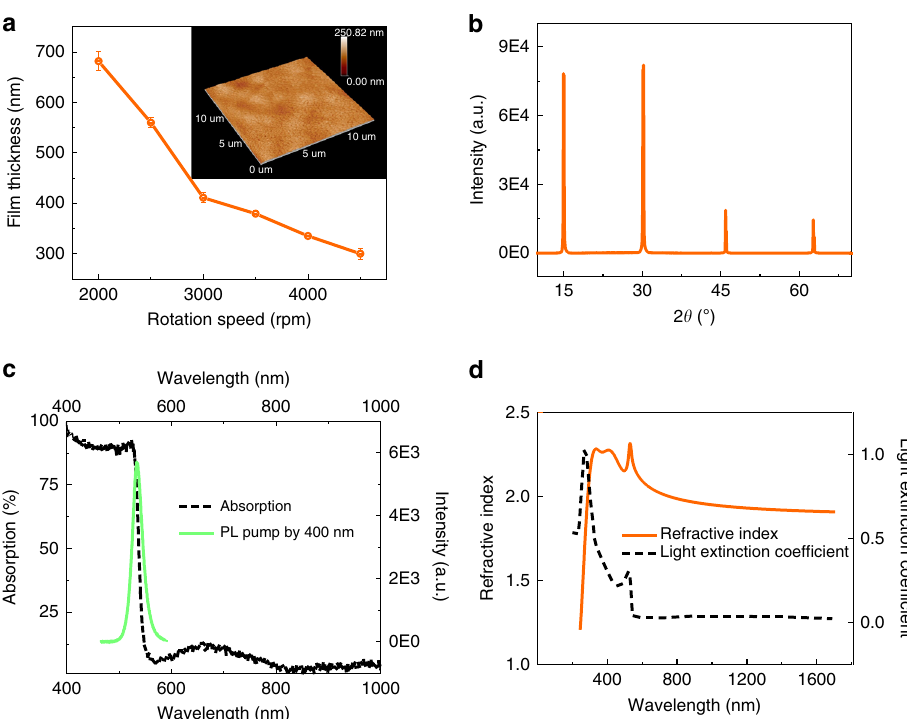
Fig. 1 The synthesized MAPbBr 3 perovskite fi lm. a The thickness of MAPbBr 3 perovskite fi lm as a function of spin-coating speed. The inset shows the AFM image of the perovskite fi lm. b The XRD spectrum of the MAPbBr 3 perovskite fi lm. c The absorption (dashed line) and photoluminescence (solid line) curves of the perovskite fi lm. d The refractive index (solid line) and light extinction coef fi cient (dashed line) of the synthesized perovskite fi